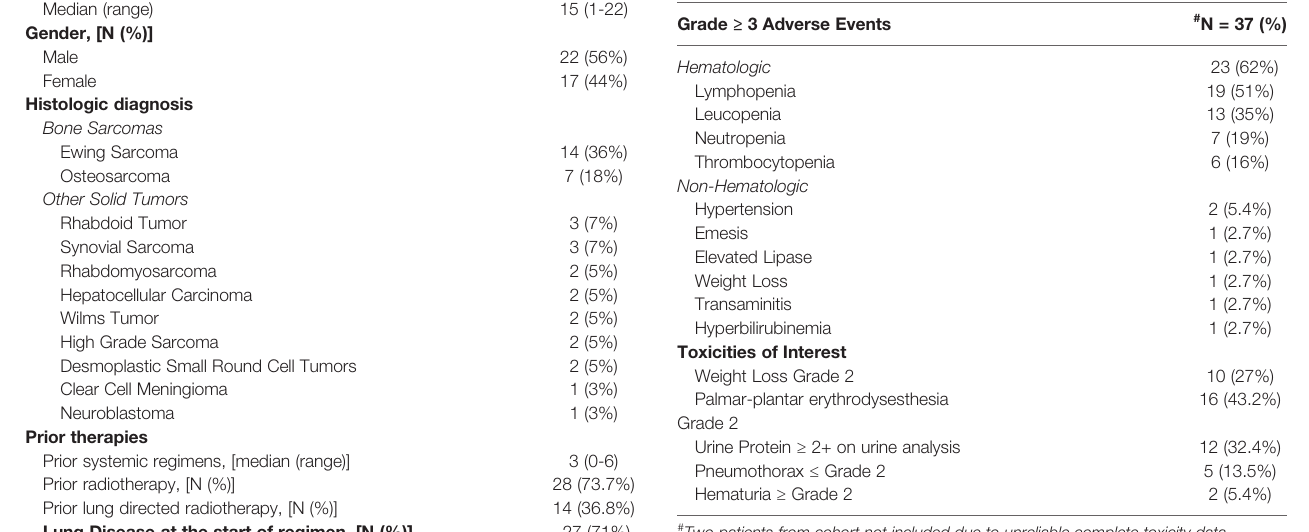
TABLE 2 | Treatment Related Toxicities and Toxicities of